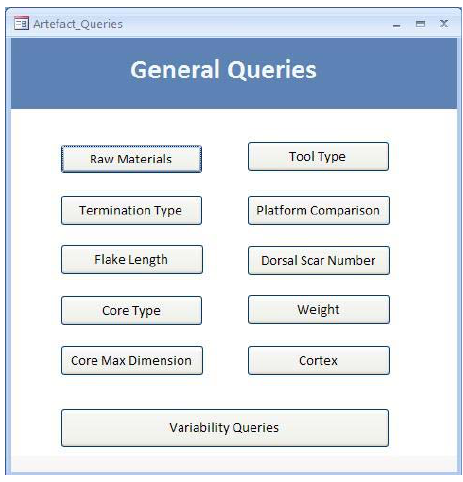
Figure 6. Interface to extract derivative